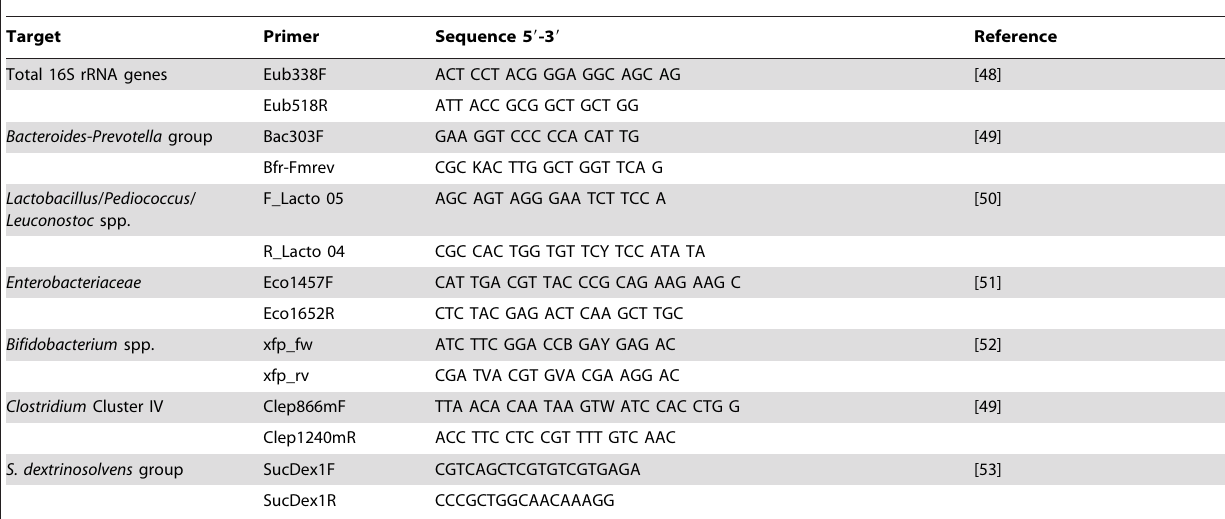
Table 1. Primers for detection of specific bacterial groups by qPCR.